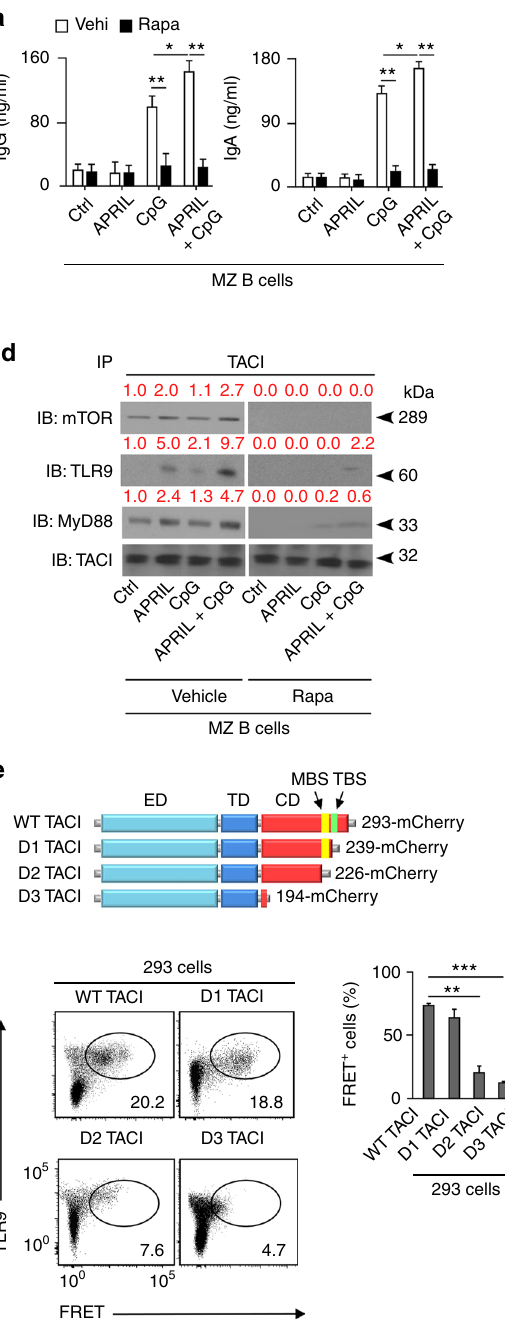
Fig. 6 TACI interacts with active TLR9 and MyD88 through mTORC1. a ELISA of total IgG and IgA from human splenic MZ B cells cultured with or without APRIL and/or CpG and in the presence of control vehicle (vehi) or rapamycin (rapa) for 5 days. Ctrl, medium alone. b Frequency of viable cells, proliferated CFSE lo cells and CD19 + CD27 hi CD38 hi plasmablasts after culturing human splenic MZ B cells as in a . Proliferation data derive from experiments identical to those in Fig. 1e, which includes comparisons between MZ and follicular B cells with no exposure to rapamycin. c qRT-PCRs of mRNAs for BLIMP-1 ( PRDM1 ), XBP-1 ( XBP1 ), and PAX5 ( PAX5 ) from human splenic MZ B cells cultured for 72 h as in a . Results are normalized to β -actin mRNA and presented as relative expression (RE) compared to B cells incubated with medium alone (ctrl). d IB of mTOR, TLR9, MyD88, and TACI following IP with an anti-TACI antibody of protein lysates from splenic IgD + B cells cultured for 60 min with or without APRIL and/or CpG in the presence of control vehicle or rapamycin. Ctrl, medium alone. Red numbers indicate band intensity relative to TACI bands. e Top schematics: structure of mCherry-tagged WT TACI or D1, D2, and D3 TACI deletion mutants (acceptors) used in FRET assays. Bottom graphs: FCM of FRET signal in co-transfected 293 cells expressing donor TLR9-eYFP together with mCherry-tagged WT or mutant acceptor TACI proteins as well as frequency of FRET + 293 cells ( f ) IFA of 293 cells stained for transfected TACI (red) and TLR9 (green) as well as endogenous endosomal Rab7 (magenta). Bar, 10 μ m. White arrows indicate endosomal TACI-TLR9 co-localization. Data summarize two experiments with at least two donors in each experimental group ( a , c , e ), show one representative experiment of at least three with similar results ( d , f ), or correspond to three biological replicates for each cell type ( b ). Error bars, s.e.m.; * p < 0.05, ** p < 0.01, *** p < 0.001 (two-tailed Student ’ s t